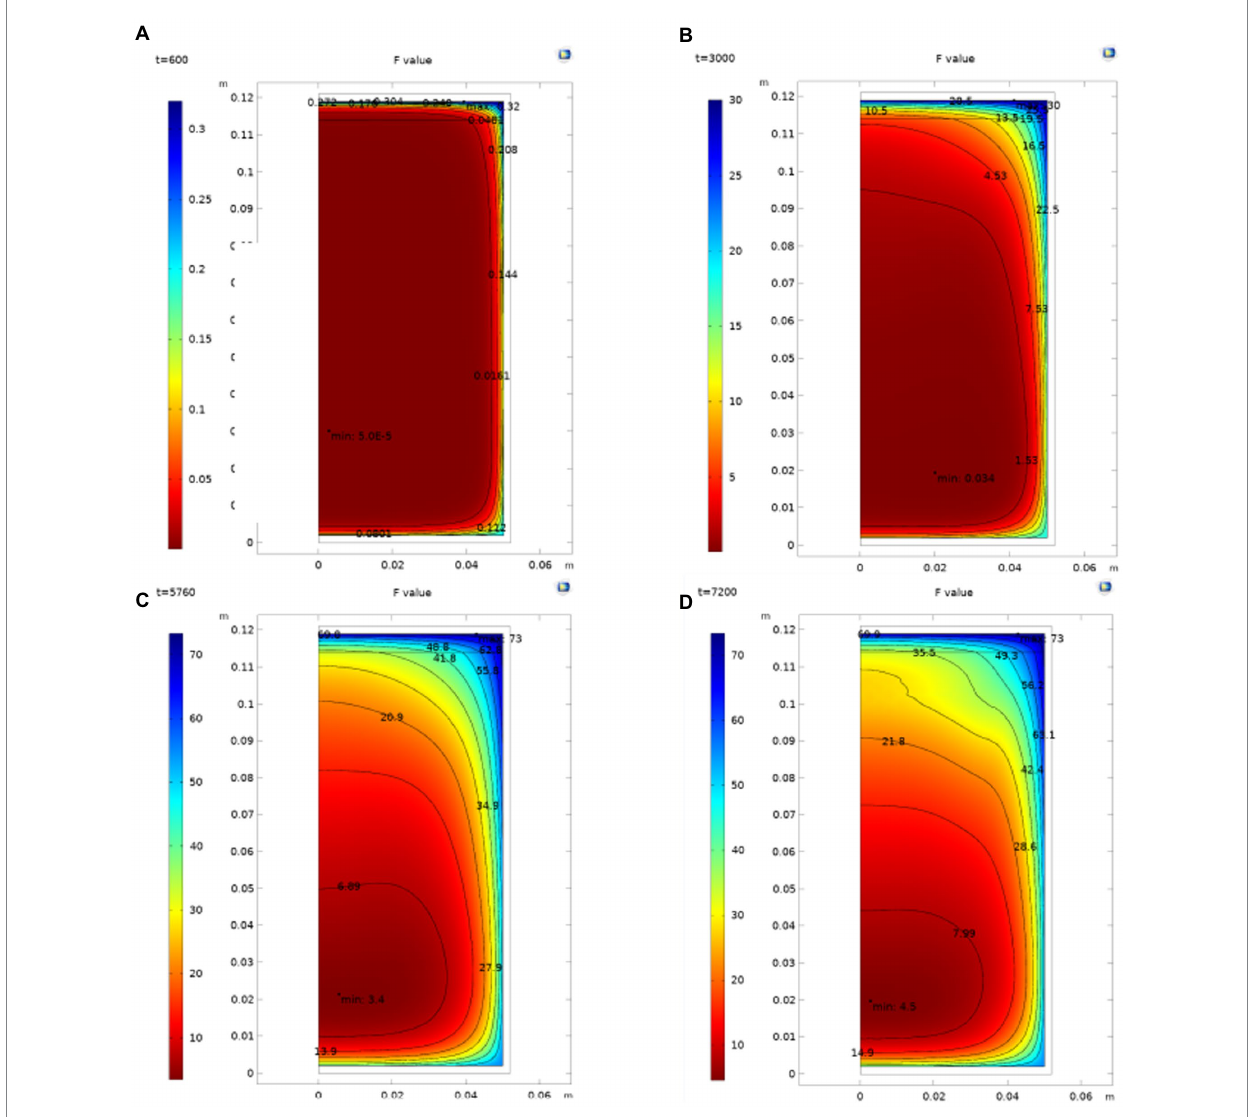
FIGURE. 4 Distribution of the F value in the can. (A) the F value distribution in can when t = 600 s; (B) Flow distribution in can when t = 3,000 s; (C) Flow distribution in can when t = 5,760 s; (D) Flow distribution in can when t = 7,200